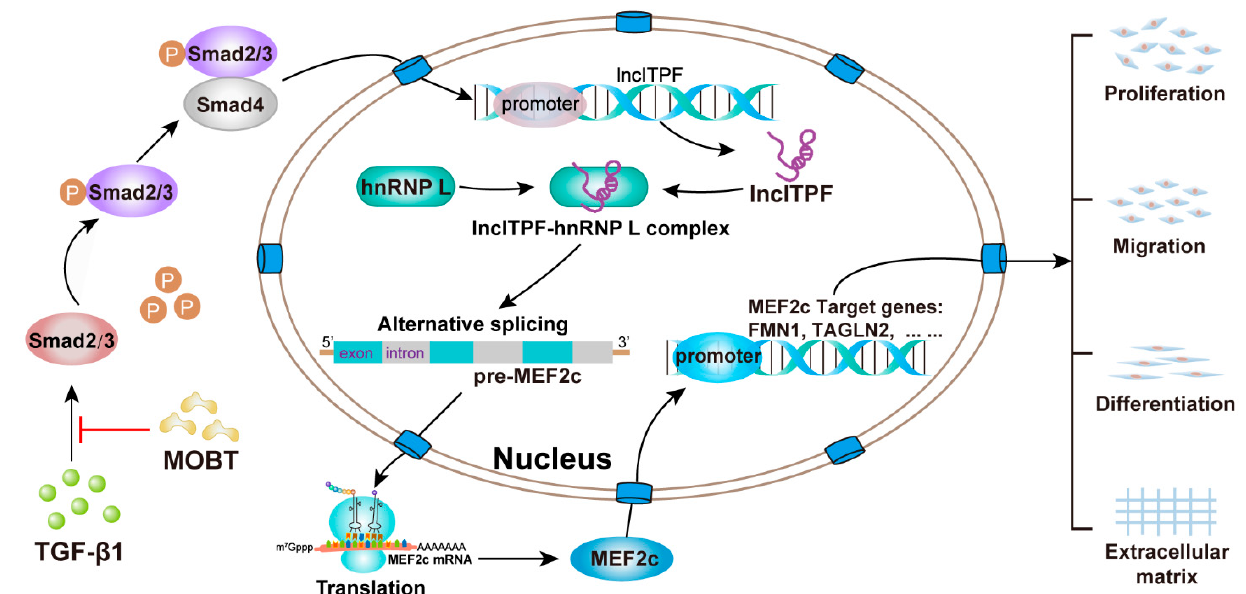
Figure 8. Anti-pulmonary fibrotic mechanism of MOBT. MOBT inhibited lncITPF transcription by preventing p-Smad2/3 translocation from the cytoplasm to the nucleus, resulting in the reduction of the lncITPF–hnRNP L complex. The decreased lncITPF–hnRNP L complex reduced MEF2c expression by blocking its alternative splicing, which in turn inhibited the expression of MEF2c target genes, such as TAGLN2 and FMN1.